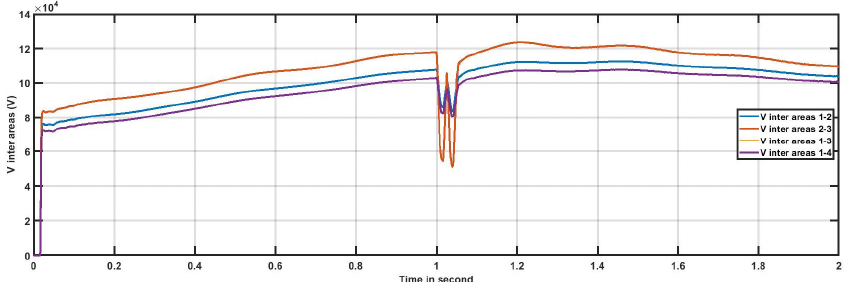
Figure 16. Inter-area voltage for 3LG permanent fault at location B. Table 6. Voltage indices of PV